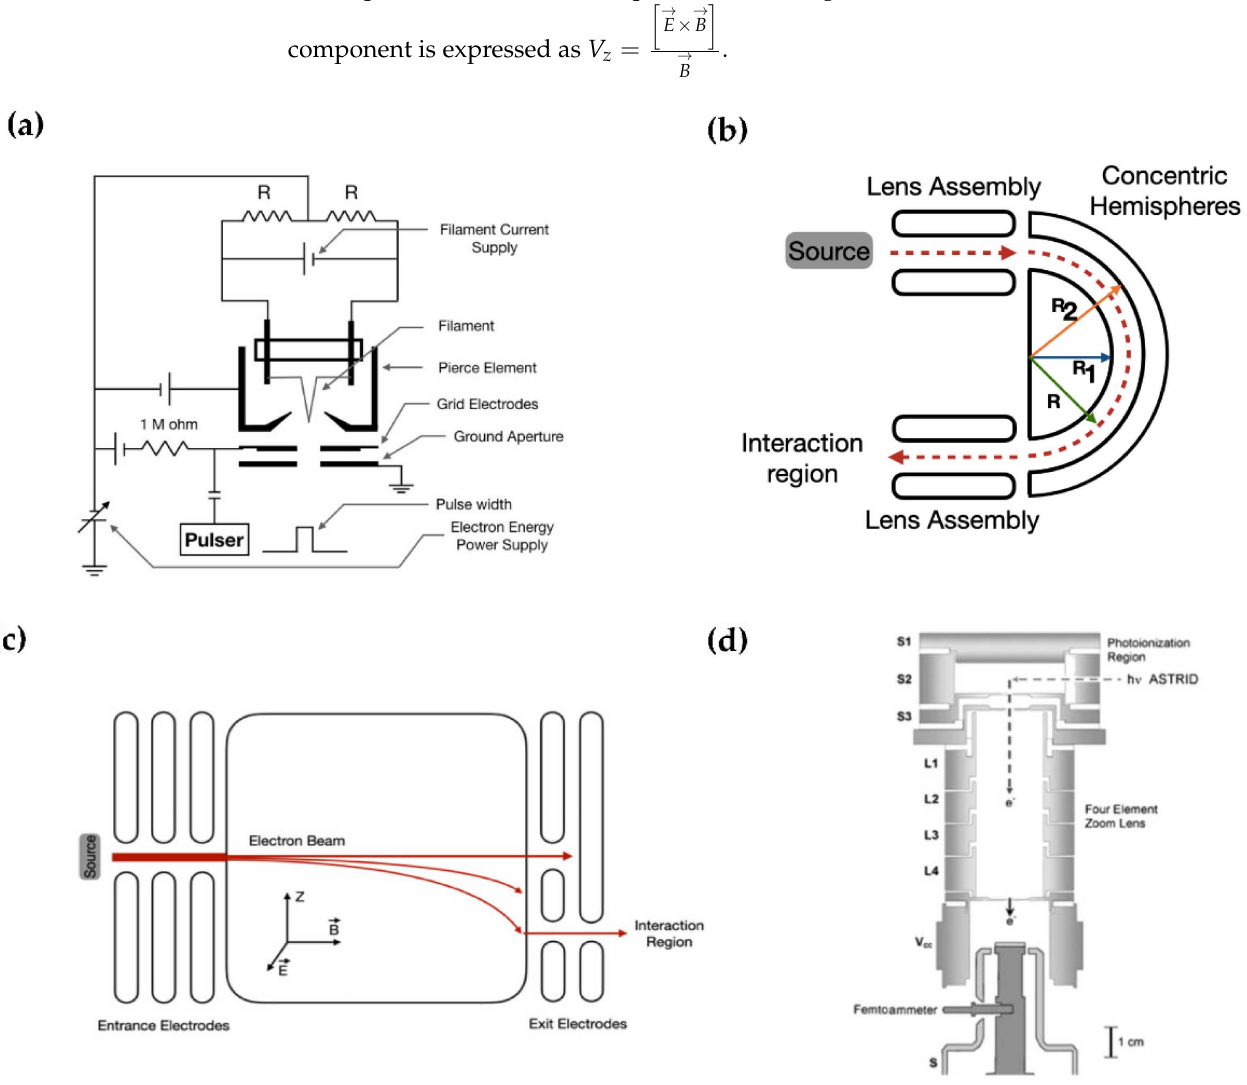
Figure 2. Schematic diagram of ( a ) the standard electron gun showing the biasing voltages and mechanism to produce a pulsed electron beam; ( b ) the hemispherical electron monochromator (HEM) with lens assemblies to focus the diverging electron beam and produce a high-resolution electron beam (the red dashed-line indicates the expected path of the electron beam); ( c ) the trochoidal electron monochromator (TEM) consisting of a set of electrostatic lenses supplied by stable and precise power supplies, and ( d ) photoionization, in which synchrotron radiation enters a source that contains argon, and the resulting photoelectrons, expelled by a weak electric field, are focused on the target region (adapted from [51] with